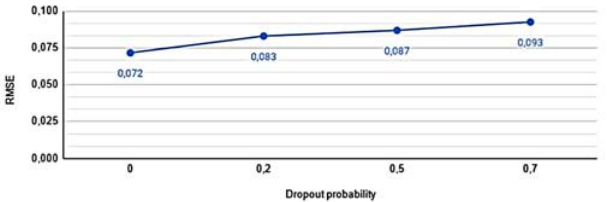
Figure 25. Average RMSE trend concerning dropout probability for the validation set on 2 h predic- tion horizon.